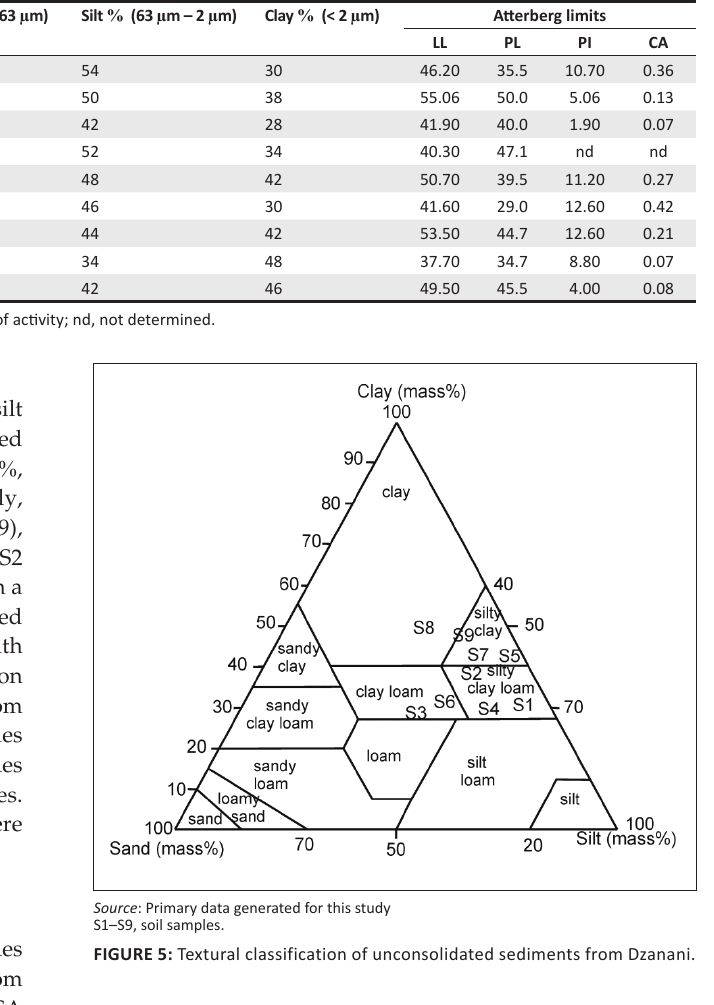
TABLE 1: Soil physical properties. Sample